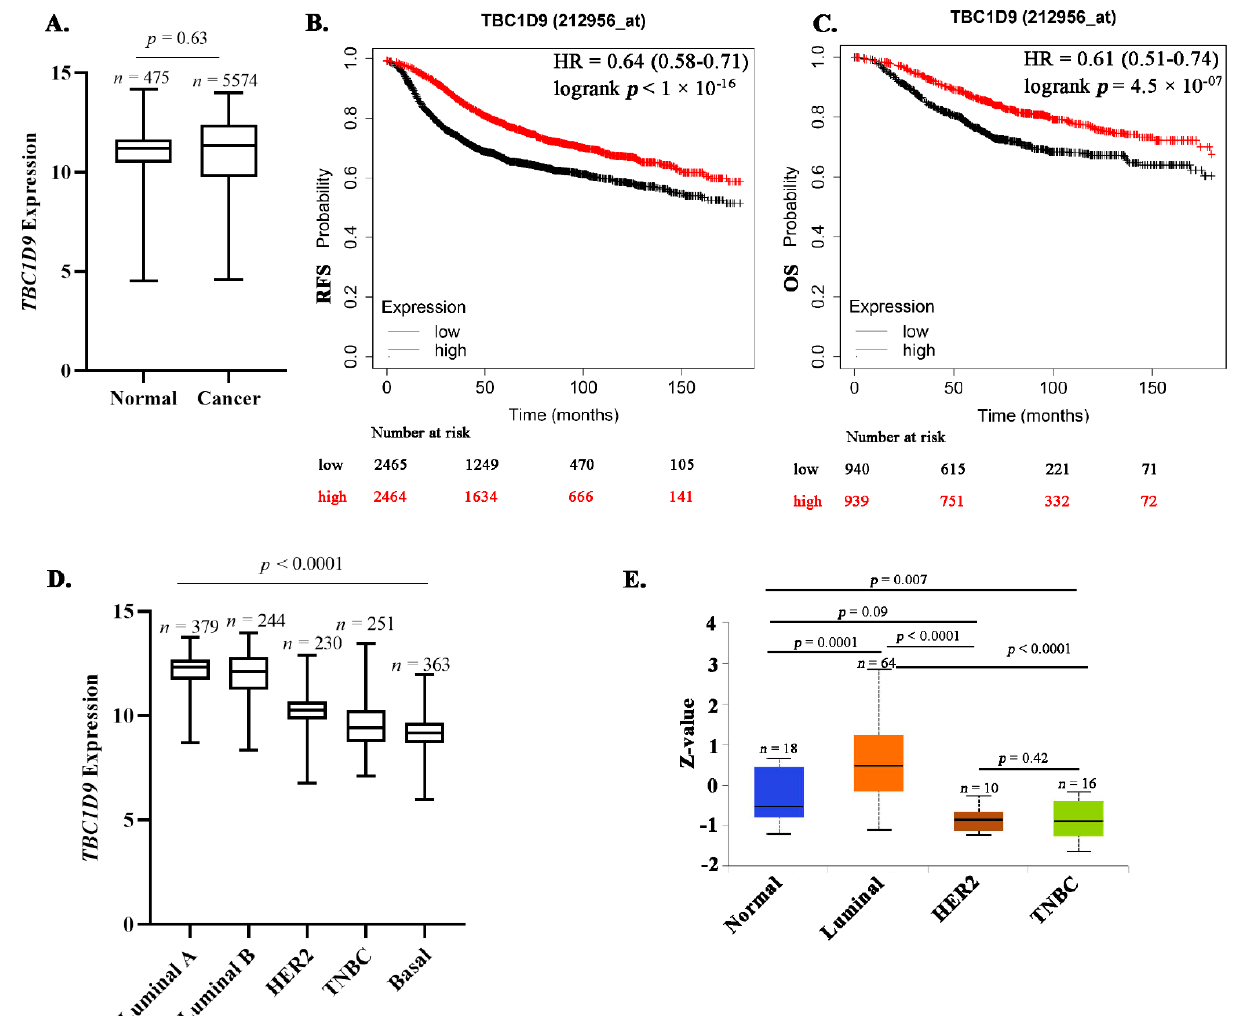
Figure 1. Expression of TBC1D9 in publicly available BC datasets and its effect on survival. TBC1D9 expression in normal ( n = 475) vs. BC ( n = 5574) tissue samples (GENT2 database; http://gent2.appex.kr/gent2/, accessed on 14 June 2021) ( A ). Effect of TBC1D9 on the survival outcome of BC patients: RFS ( B ) and OS ( C ) (https://kmplot.com/analysis/, accessed on 14 June 2021). HR = hazard ratio. TBC1D9 expression in different subtypes of BC: mRNA (GENT2 database) ( D ) and protein (UALCAN database; http://ualcan.path.uab.edu/, accessed on 14 June 2021) ( E ).